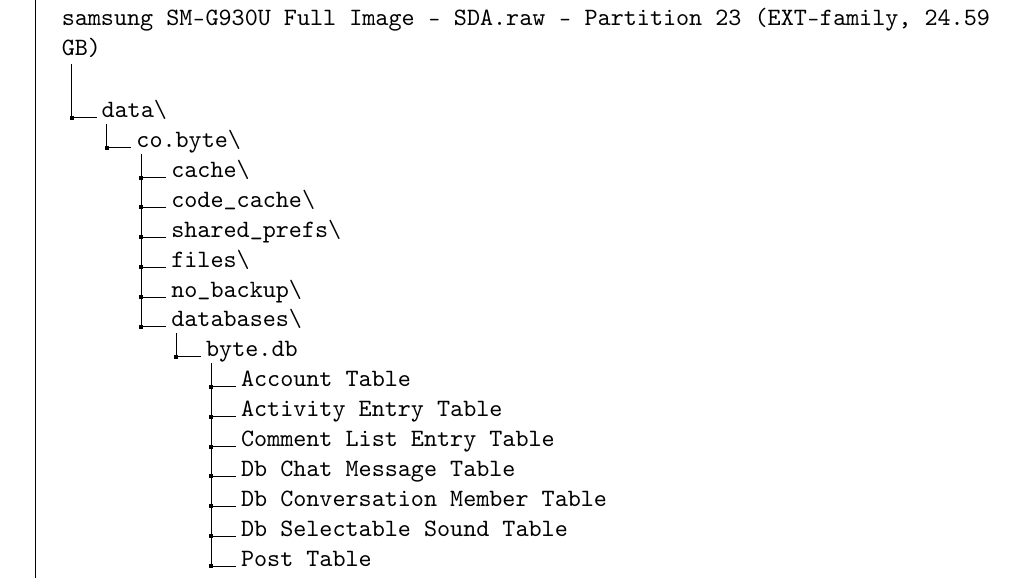
Figure 6. Byte Android file structure as captured in Magnet AXIOM